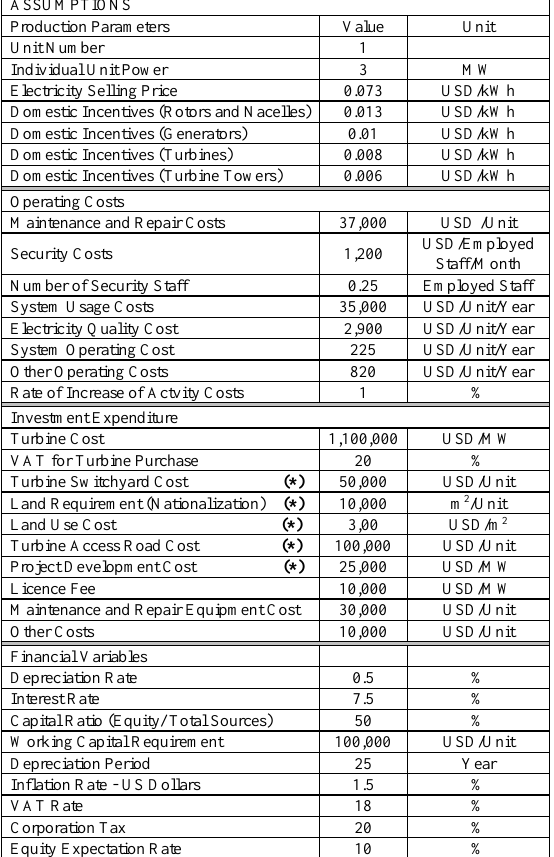
Table 1: Input variables defined as assumptions for wind energy investment and assumptions for wind turbine